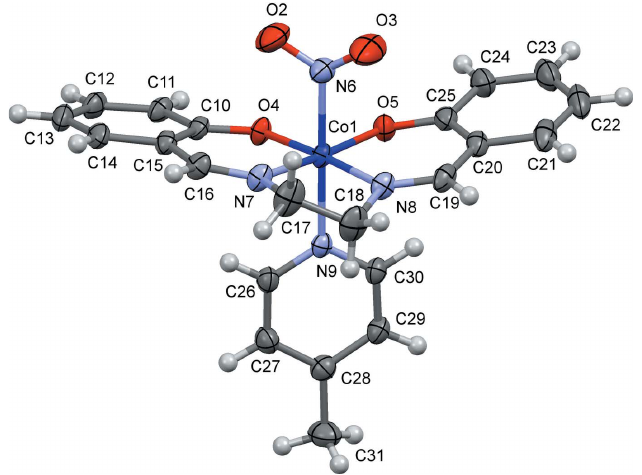
Figure 2 The molecular structure of (II), showing displacement ellipsoids at the 30% probability level.